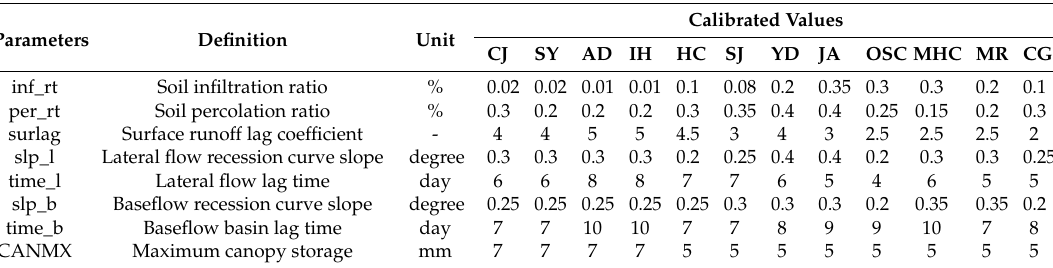
Table 2. Model calibrated